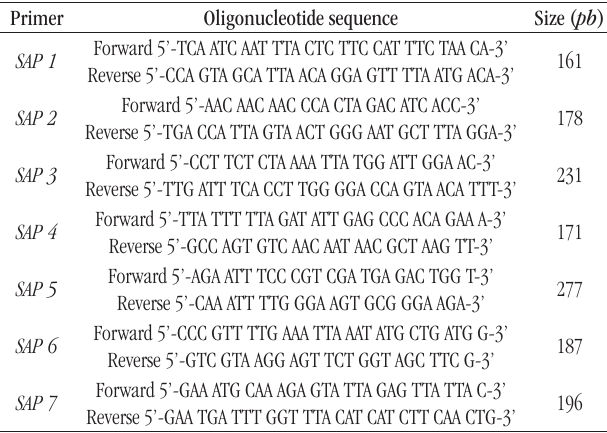
taBLE 1 − Oligonucleotide sequences used in PCR assays for investigation of virulence